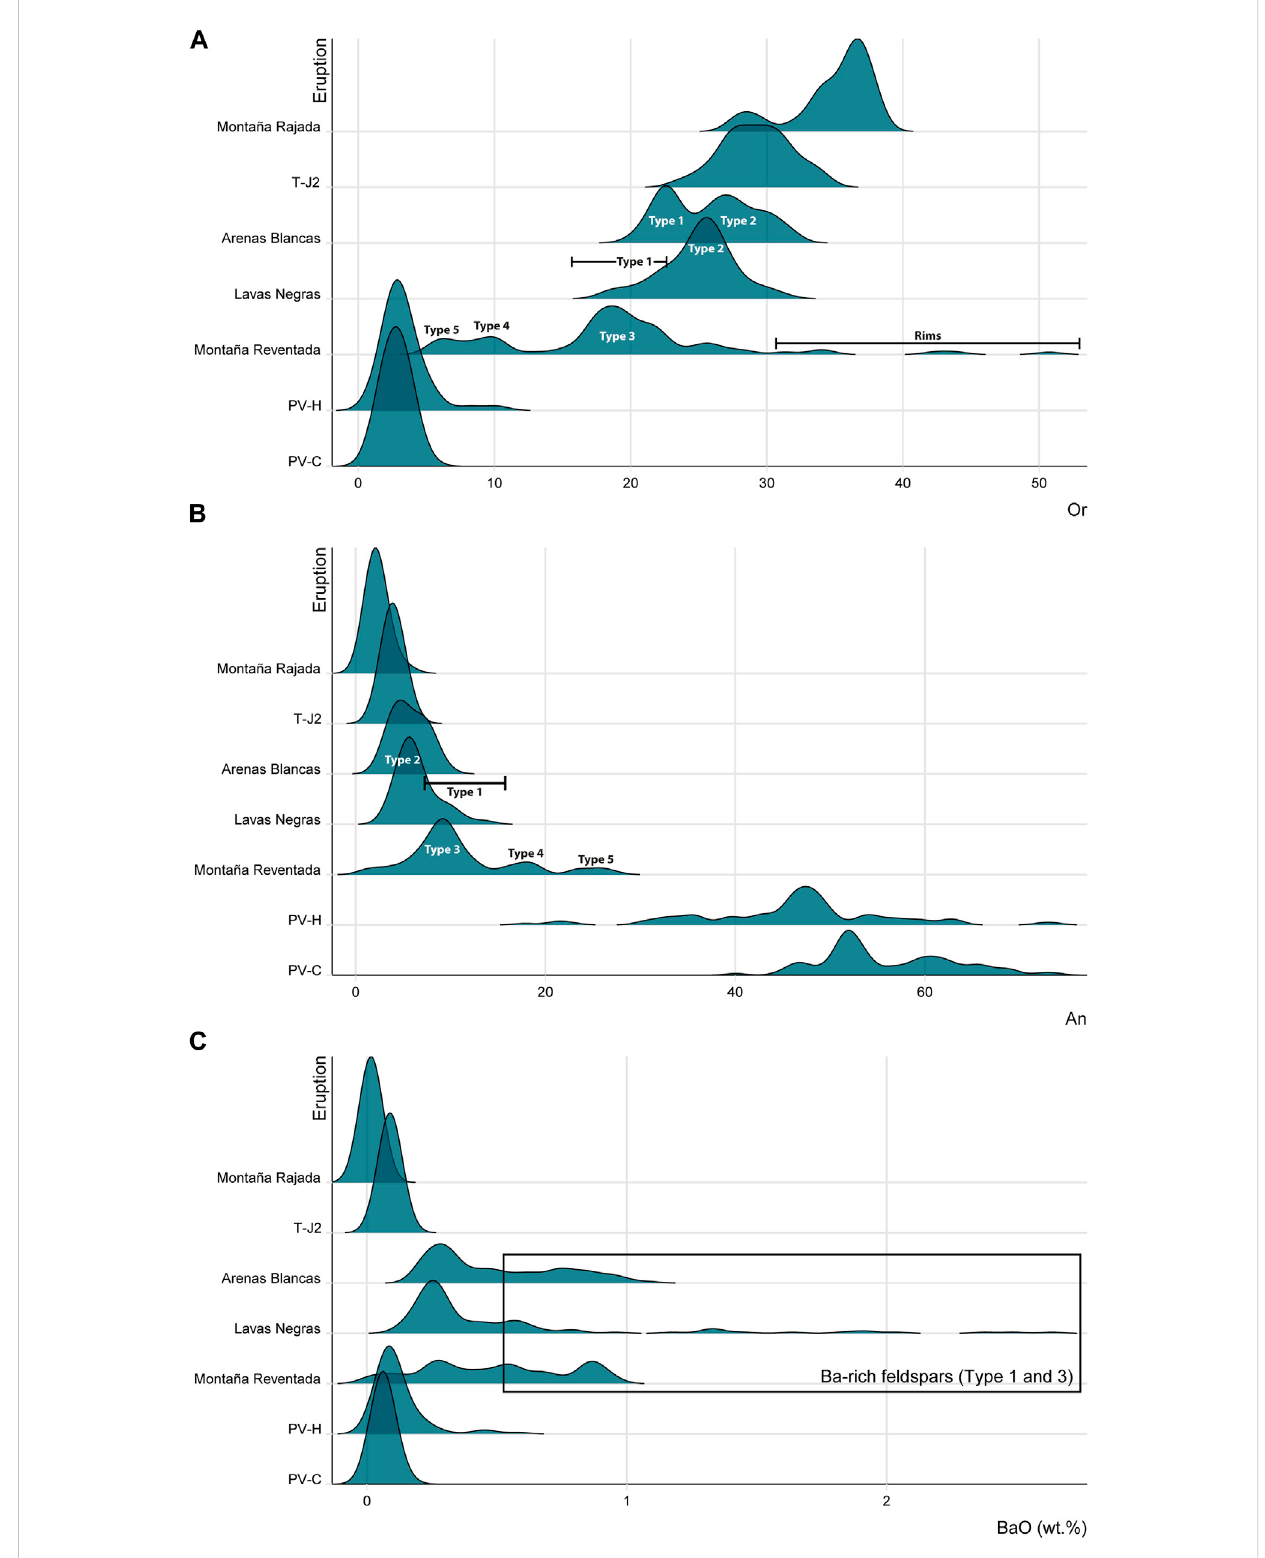
FIGURE 8 Probability density function plots of (A) Or, (B) An and (C) BaO (wt%) of feldspar EPMA analyses, showing the data distributions for each eruption. Note multiple populations for the Lavas Negras, Arenas Blancas and Montaña Reventada eruptions.